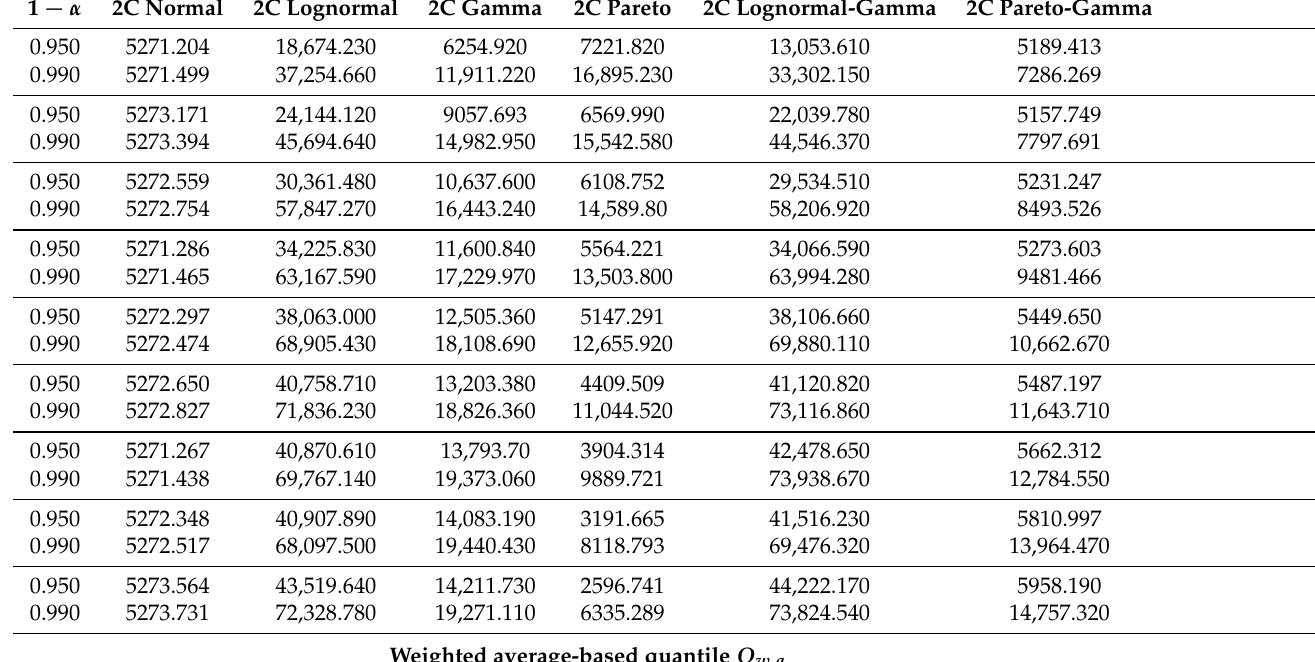
Table 2. Comparison between the finite mixture model-based (1 − α ) quantile Q mix . and the weighted average-based (1 − α ) quantile Q w . a . derived for the various parametric families considered in this study. Note that (1 − α ) denotes the probability level at which the quantile is computed. The quantile Q mix . is calculated by using the derived EM parameters and weights estimates shown in Table 1. For the computation of quantile Q w . a . , no model estimation is involved, and it is calculated as the weighted average of two individual quantiles, each coming from a distribution family with parameters and weights as those used to generate the data. Finite Mixture Model-Based Quantile Q mix